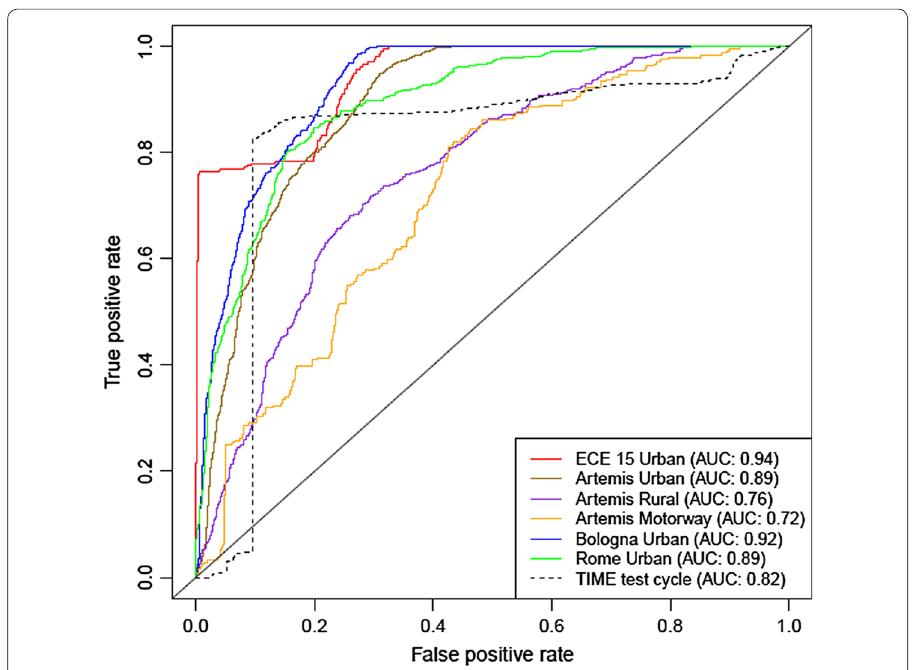
Fig. 6 ROC curves on the seven driving